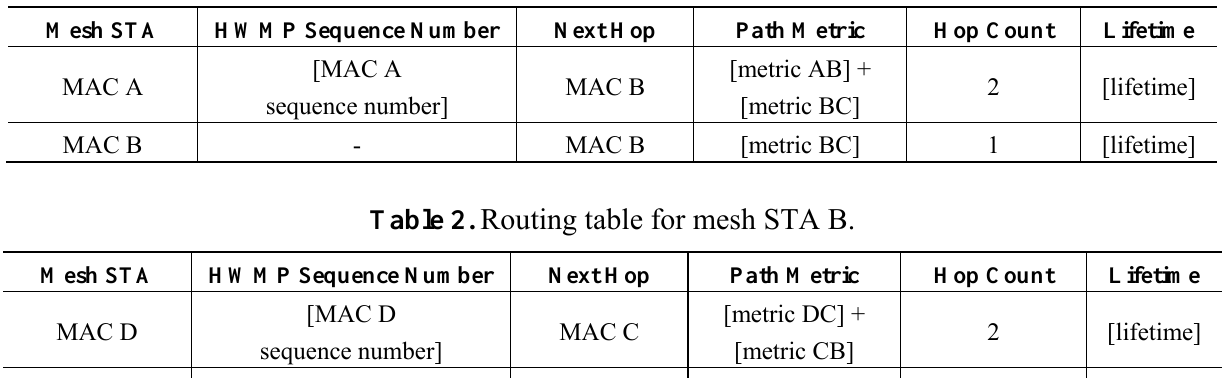
Table 1. Routing table for mesh STA C.